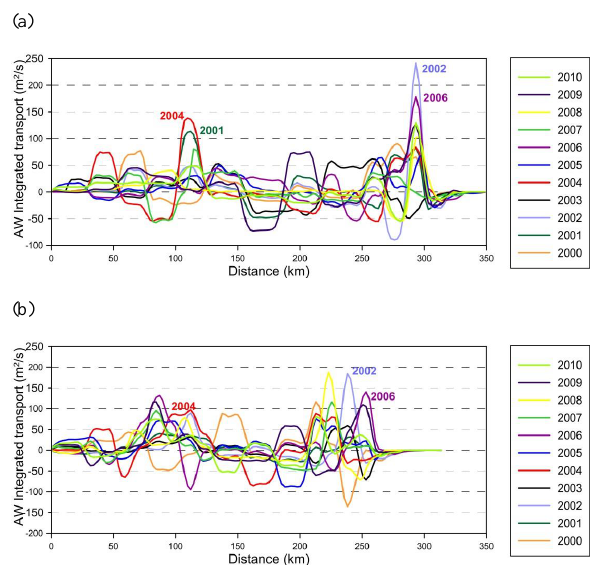
Fig. 16. Vertically integrated baroclinic volume transport (m 2 s − 1 ) cross the section (a) “K” along the 75 ◦ N parallel and (b) “N” along Figure 16. Vertically integrated baroclinic volume transport (m 2 · s -1 ) cross the section (a) ‘K’ 6 the 76 ◦ 30 0 N parallel. along the 75° N parallel and (b) ‘N’ along the 76°30’ N parallel. 7